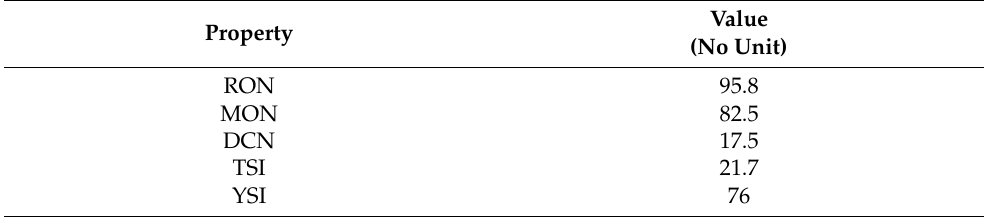
Figure 3. Architecture of a neural network model foe RON and MON prediction. Table 3. Predicted fuel properties from the functional groups.